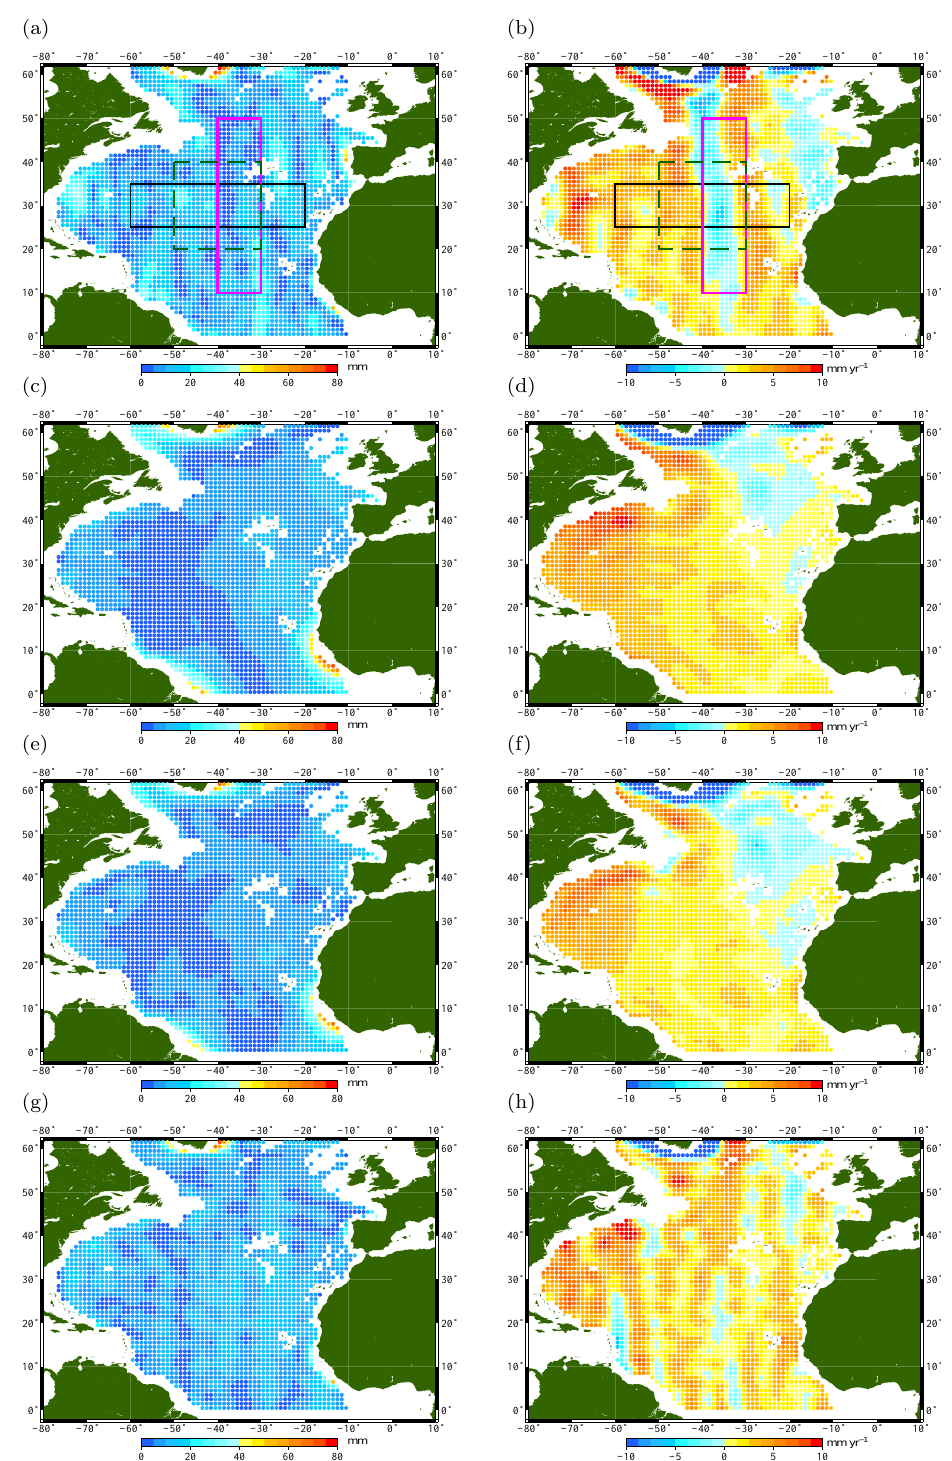
Figure 6. (Caption on previous page.) Amplitudes of the annual signal (left) and trends (right) of the mass signal. The first to the third row show the CSR96-DDK solutions (a, b) , the CSR60-W (c, d) and CSR96-W (e, f) solutions, respectively. The fourth row shows the ITSG90- W (g, h) solution. In the top graphs, three polygons are plotted: a meridionally oriented rectangle (purple line), a zonally oriented rectangle (black line) and a square (green dashed line) from which mean MC time series are computed